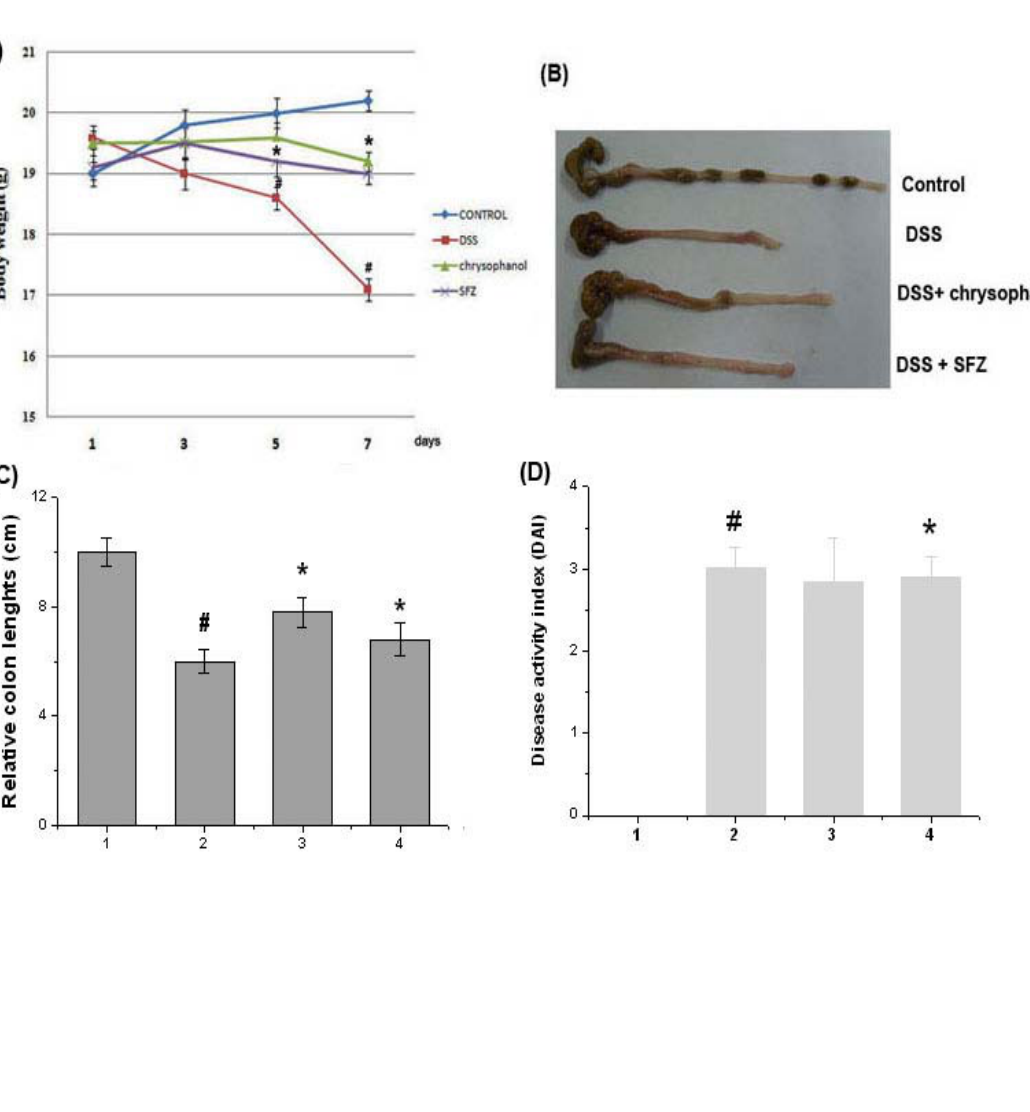
Figure 1. Effect of chrysophanol on clinical signs in DSS-induced colitis. Experimental colitis in mice was induced by a 5% DSS dissolved in the drinking water for 7 days. Chrysophanol was administered at doses of 5 mg/kg once a day for 7 days prior to 5% DSS supplement. (A) Body weight of mice was measured; (B) The colons were removed at day 7 after DSS treatment, and the colon lengths were measured; (C) Relative colon lengths were represented; (D) DAI was calculated as described in the Experimental. Sulfasalazine (150 mg/kg) was used as a positive control. (1) Control group; (2) DSS alone-treated group; (3) chrysophanol (5 mg/kg) + DSS treated group; (4) sulfasalazine (150 mg/kg) + DSS treated group. Values were represented in the mean ± S.E.M. (n = 5) of duplicate determinations from triplicate separate experiments ( # p < 0.05 vs. control, * p < 0.05 vs. DSS